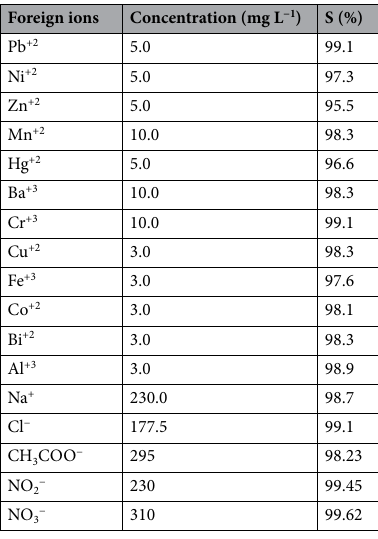
Table 3. Tolerance limits for the determination of 1.0 × 10 −6 mol L −1 Pd (II).